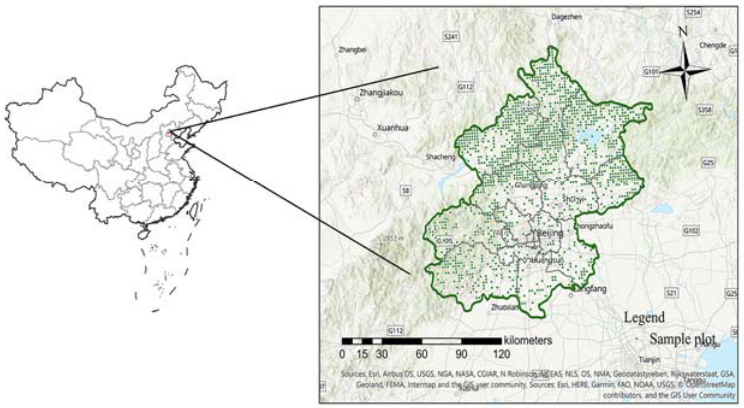
Figure 1. Spatial distribution map of the forest sample plots in Beijing. Table 1. Statistics of the main forest inventory dataset (plot number and biomass of the three forest types in Beijing, China).